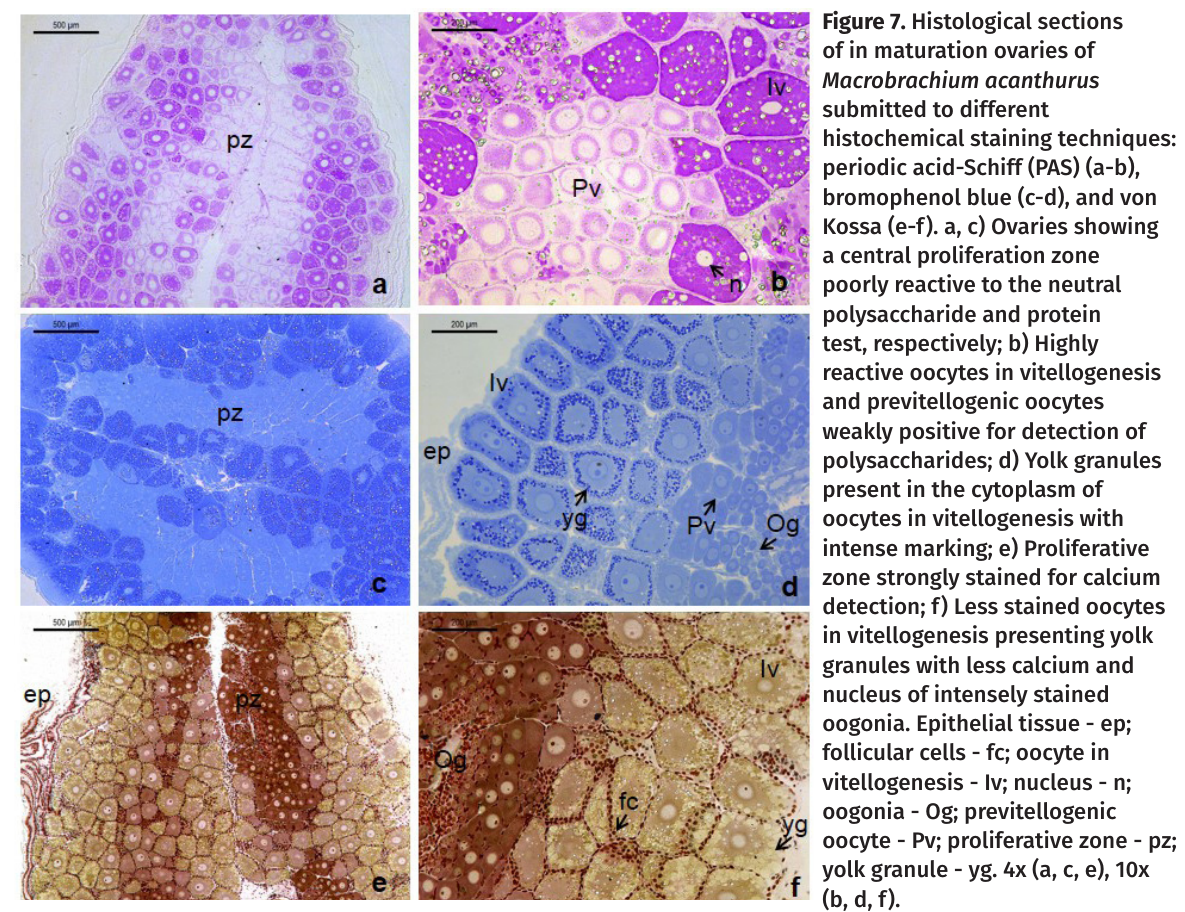
Figure 7. Histological sections of in maturation ovaries